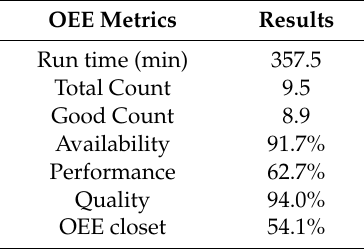
Table 4. OEE Horizontal results.